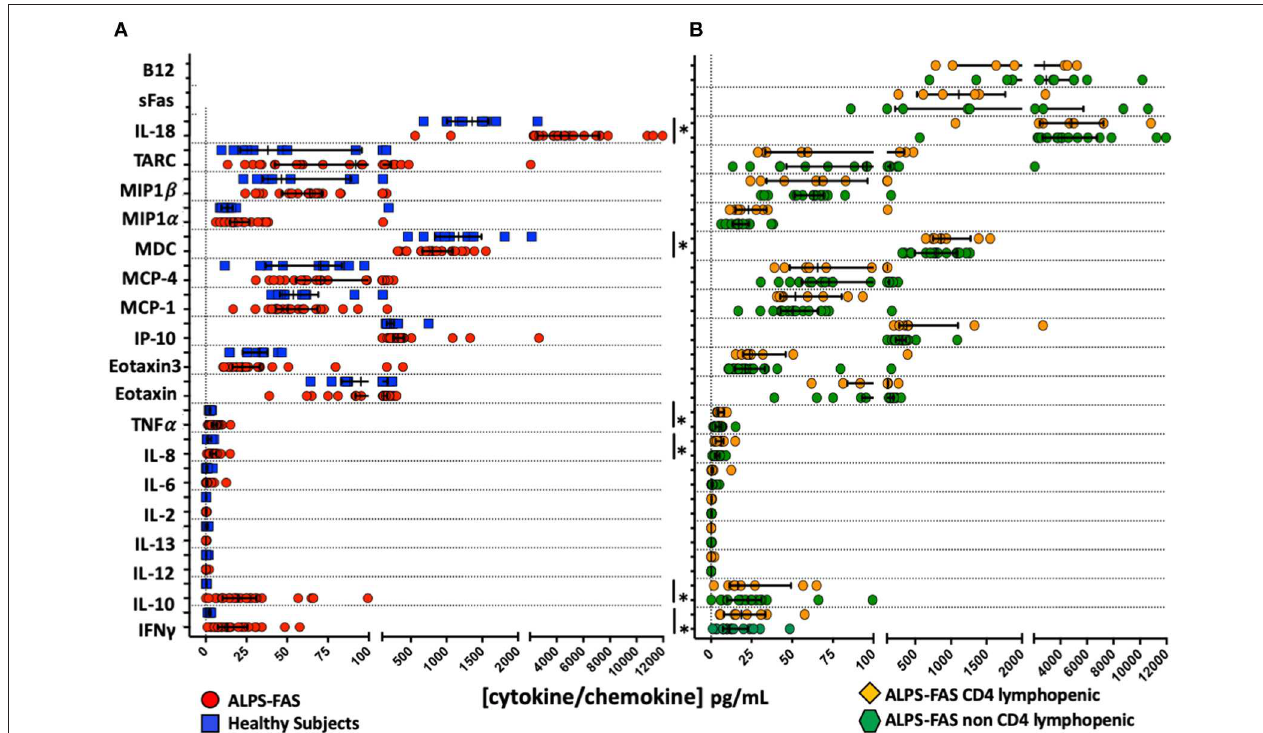
FIGURE 4 | Plasma concentration of cytokines and chemokines involved in inflammatory responses and regulation of T cell function. *Comparisons with statistically significant differences. (A) Plasma concentration of cytokines and chemokines in patients with ALPS-FAS (red circles) and healthy subjects (blue squares). (B) Plasma concentration of cytokines and chemokines in patients with ALPS-FAS with (orange diamonds) or without (green exagons) CD4